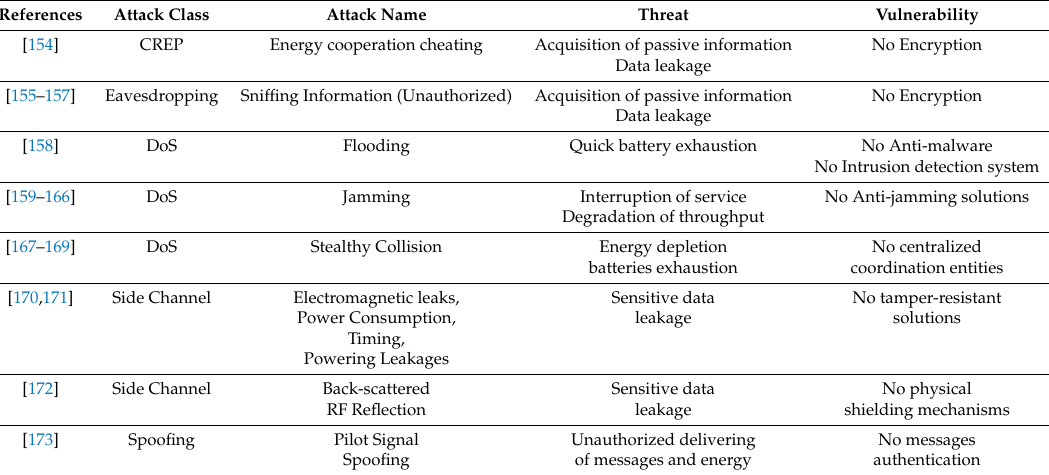
Table 6. Overview of attacks affecting energy harvesting